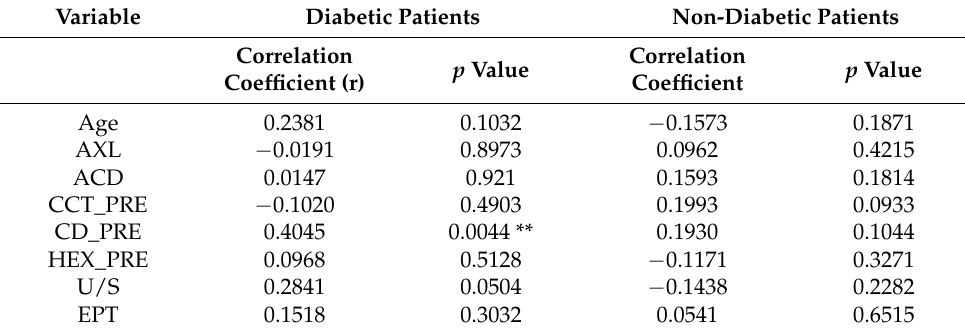
Table 2. Univariate association of the measured variables with the cell density loss.